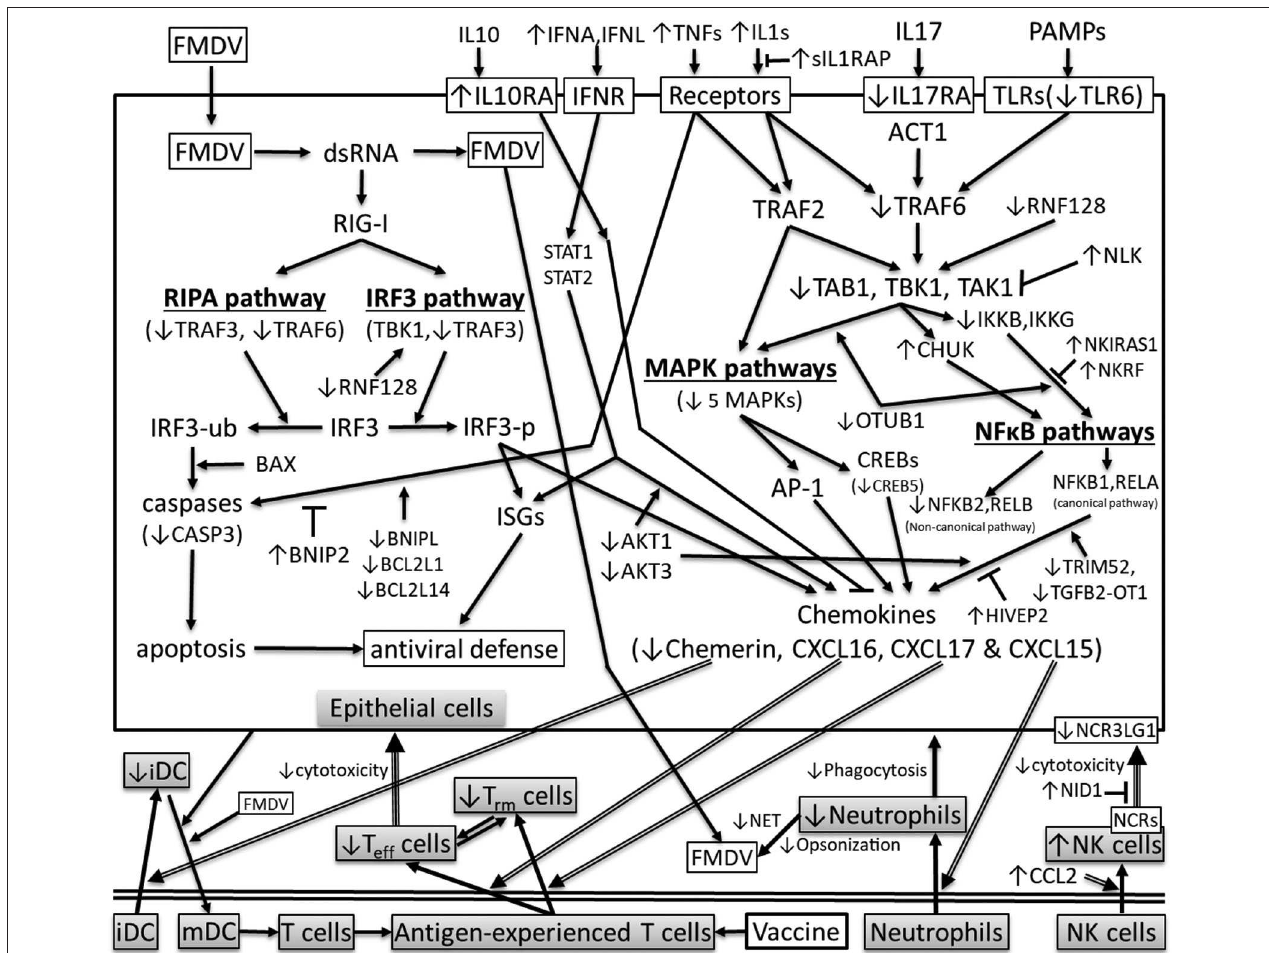
FIGURE 3 | Differentially expressed genes in cytokine signaling pathways that could affect the transcriptions of chemerin, CXCL15, CXCL16, and CXCL17 in the pharyngeal epithelial cells of FMDV carriers ( ↑ or ↓ : significantly up- or downregulated in carriers compared to non-carriers, respectively; arrow: stimulation; ⊤ inhibition; iDC and mDC: immature and mature DC; IRF3-ub and IRF3-p: ubiquitinated and phosphorylated IRF3, respectively; ISGs: interferon-stimulated genes; MAPKs: mitogen-activated protein kinases; NCRs: NK cell receptors; NET: neutrophil extracellular traps; RIPA: RIG-I-like receptor-induced IRF3 mediated pathway of apoptosis; T eff : effector T cells; T rm : memory T cells; double line arrow: cell recruitment; double line: separation between epithelium and other